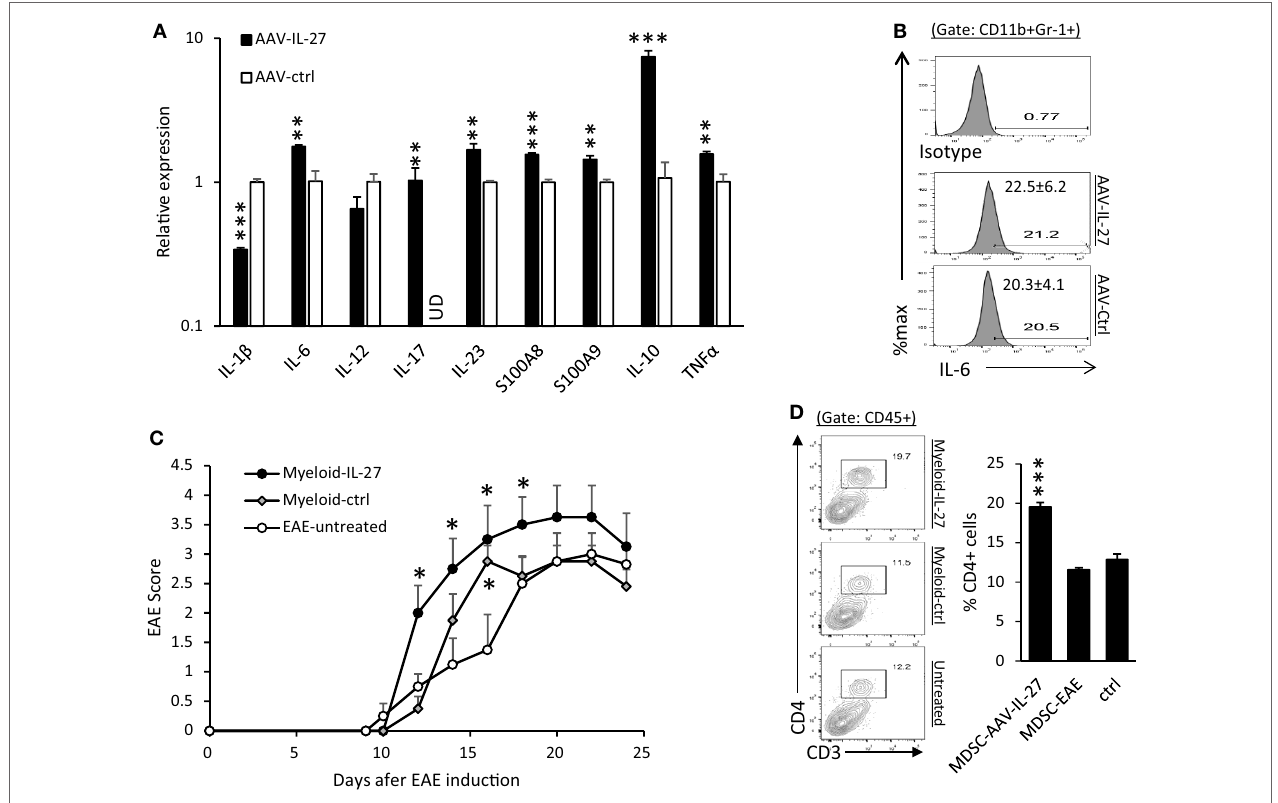
FigUre 7 | CD11b + Gr-1 + myeloid cells from adeno-associated viral vector (AAV)-interleukin-27 (IL-27)-treated mice enhance experimental autoimmune encephalomyelitis (EAE) development. (a) Myeloid cells from AAV-IL-27-treated mice express more inflammatory cytokine genes. CD11b + Gr-1 + myeloid cells were FACS sorted from spleens of AAV-IL-27 and AAV-ctrl treated mice. The expression of cytokine genes was assessed by qPCR. The sorted cells from each treatment group ( n = 3) were mixed, and results were expressed as mean ± SD from triplicates. ud, un detectable. Data shown represent two experiments with similar results. (B) Intracellular staining and flow cytometry were used for detecting IL-6 in myeloid cells from AAV-IL-27-treated ( n = 7) or AAV-ctrl-treated ( n = 6) mice. Numbers represent mean ± SD of IL-6 + cells among the CD11b + Gr1 + population. Data shown represent two experiments with similar results. (c) Adoptive transfer of AAV-IL-27-treated CD11b + Gr-1 + myeloid cells enhances EAE development. CD11b + Gr-1 + myeloid cells were FACS-purified from AAV-IL-27 or AAV-ctrl virus-treated mice with EAE and were injected i.v. into mice (1 million cells/per mouse) on day 10 post EAE induction. The mice ( n = 4/group) were observed for EAE development. * P < 0.05 by one way ANOVA. Data shown represent two experiments with similar results. (D) CD4 + T cell expansion was observed in the central nervous system (CNS) of mice receiving AAV-IL-27-treated CD11b + Gr-1 + myeloid cells. Mice indicated in (D) were sacrificed on day 24 and flow cytometry was used to analyze the CNS-infiltrating leukocytes. *** P < 0.001 by one way